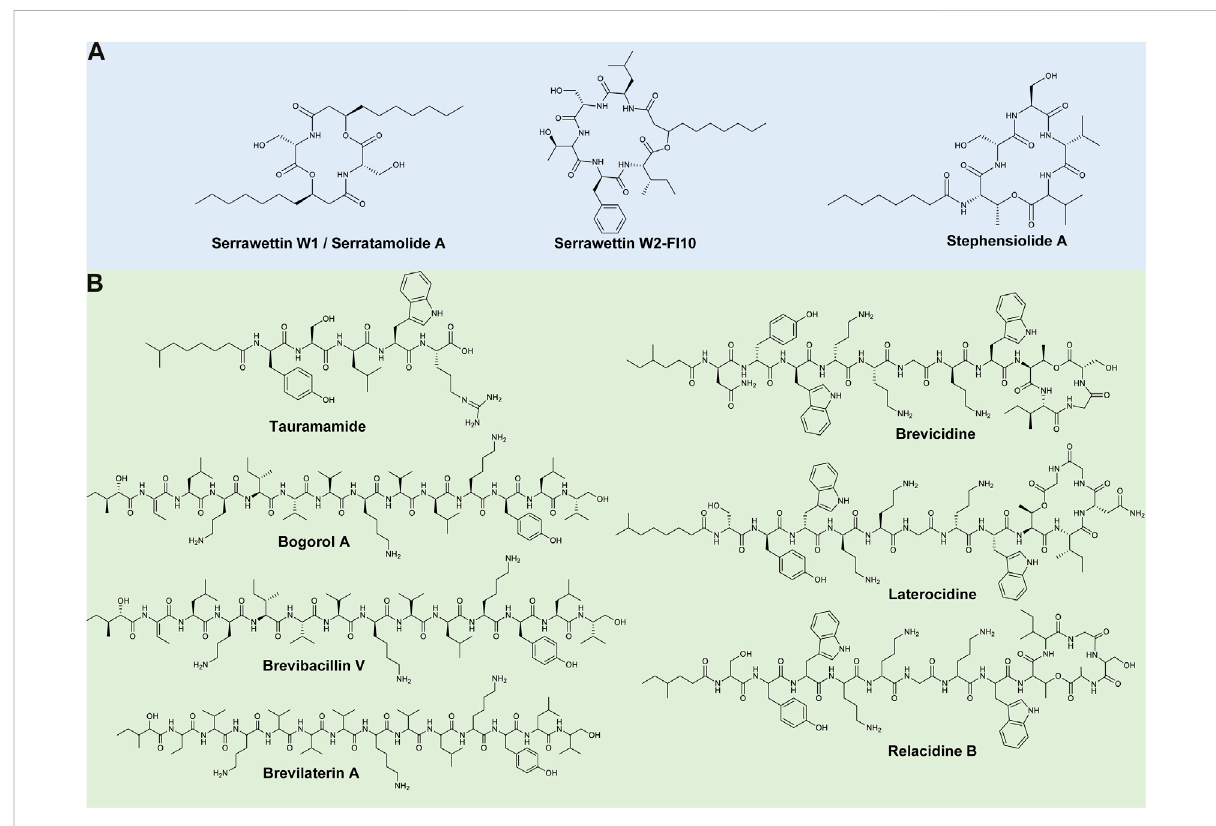
FIGURE 1 Representative lipopeptides producedby (A) Serratia and (B) Brevibacillus species. The structural information was obtained from the PubChem database (https://pubchem.ncbi.nlm.nih.gov/),as wellas thecorrespondingreferencesprovidedin-text. The structures weresubsequentlydrawnin ChemDraw Ultra version